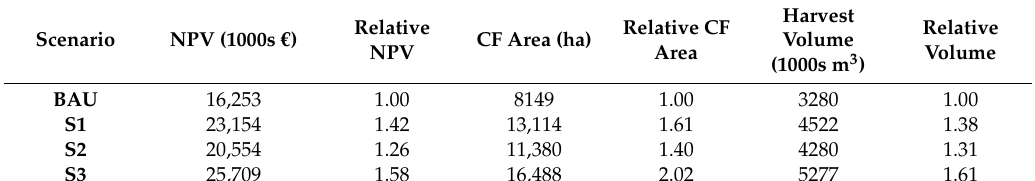
Table 7. Comparison of Net Present Value (NPV) over the 100-year planning period, relative NPV, total clearfell (CF) area, relative total CF area, total extracted harvest volume, and relative total harvest volume between the BAU and the three global scenarios. Relative values are calculated using BAU as reference.